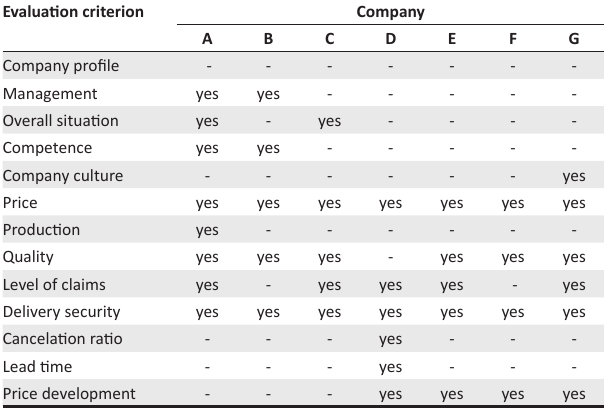
TABLE 1: Supplier evaluation criteria used by different companies.